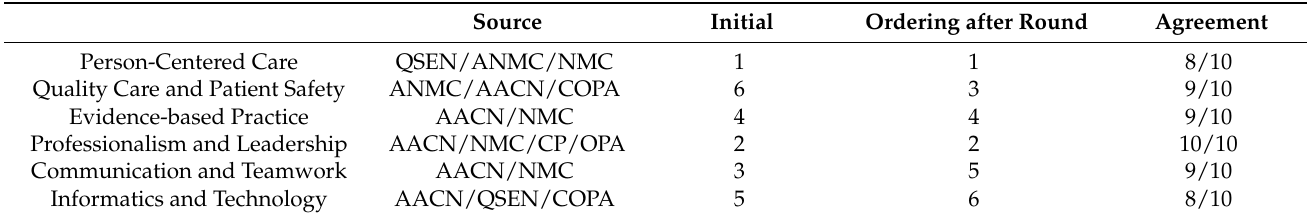
Table 2. Core Competency Domains and the ordering of the Domains after Round 1.